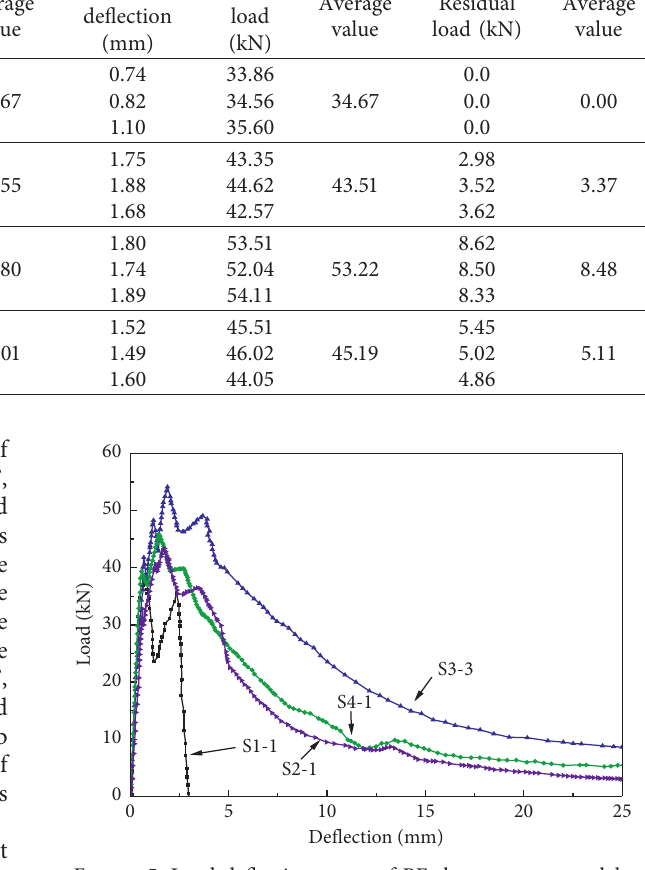
Figure 5: Load-deflection curve of BF shotcrete square